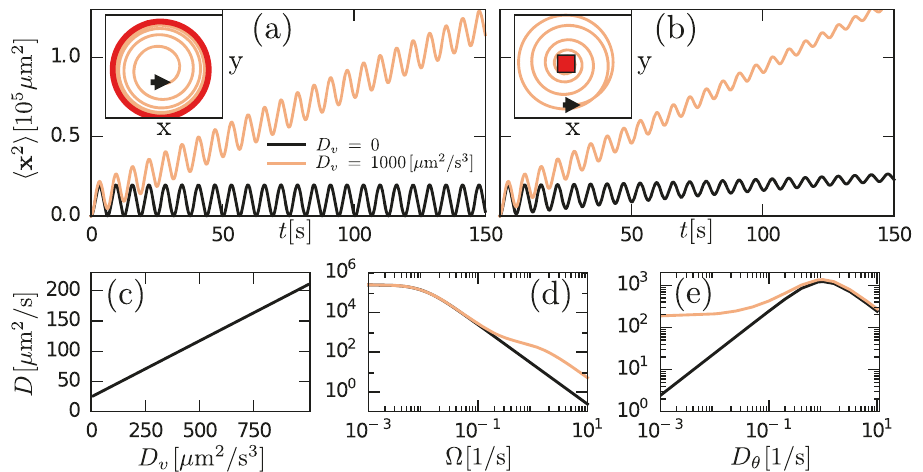
Fig. 2 Theoretical prediction for a two-dimensional chiral active particle with active speed fl uctuations. In a and b it is shown that both 〈 x ( t ) 〉 (inset) and 〈 x 2 ( t ) 〉 (main panel) evolves in time. The presence ( D D = 0) of speed fl uctuations play a different role for D = 0 ( a ) and D v > 0) or absence ( v θ θ > 0 ( b ). In particular, 〈 x ( t ) 〉 is an outward spiral that converges to a limit cycle [red circle in inset of a ], whereas in the presence of such fl uctuations we observe an inward spiral converging to a point [red square in inset of b ]. c – e display the effective diffusion coef fi cient D as function of D v , Ω , and D θ , respectively. d and e show D ( Ω ) and D ( D θ ) in the presence (orange) and absence (black) of speed fl uctuations.